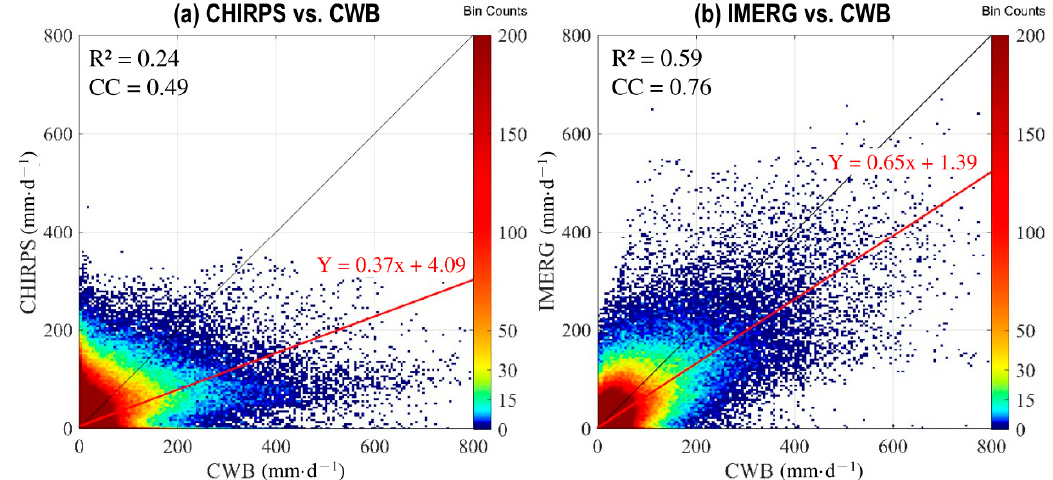
Figure 7. ( a ) Scatter plot between CWB ( x -axis) and CHIRPS ( y -axis) for all grids of daily precipitation during 2001–2019. ( b ) is similar to ( a ), but for the comparison between CWB ( x -axis) and IMERG ( y -axis). The black line represents 1:1 fit line, and the red line represents the linear regression using the equation listed. The value of coefficient of determination (R 2 ) is provided in the top left corner.